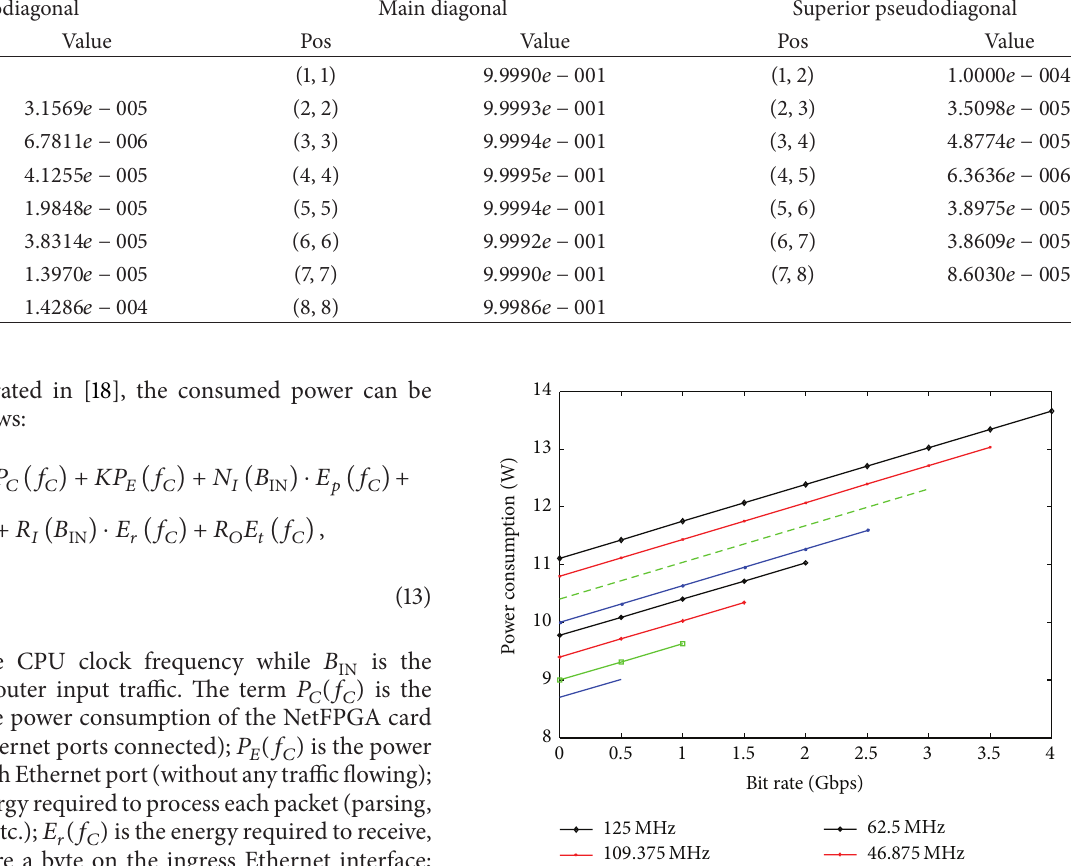
2.25, 2.75, 3.25, 3.75] Gbit/s. The considered traffic has a mean value of 2.66 Gbit/s and a standard deviation of 0.946 Gbit/s. From the traffic model (𝑄 (𝐼) , Γ (𝐼) ) we have derived a set of ten different models, obtained as follows.